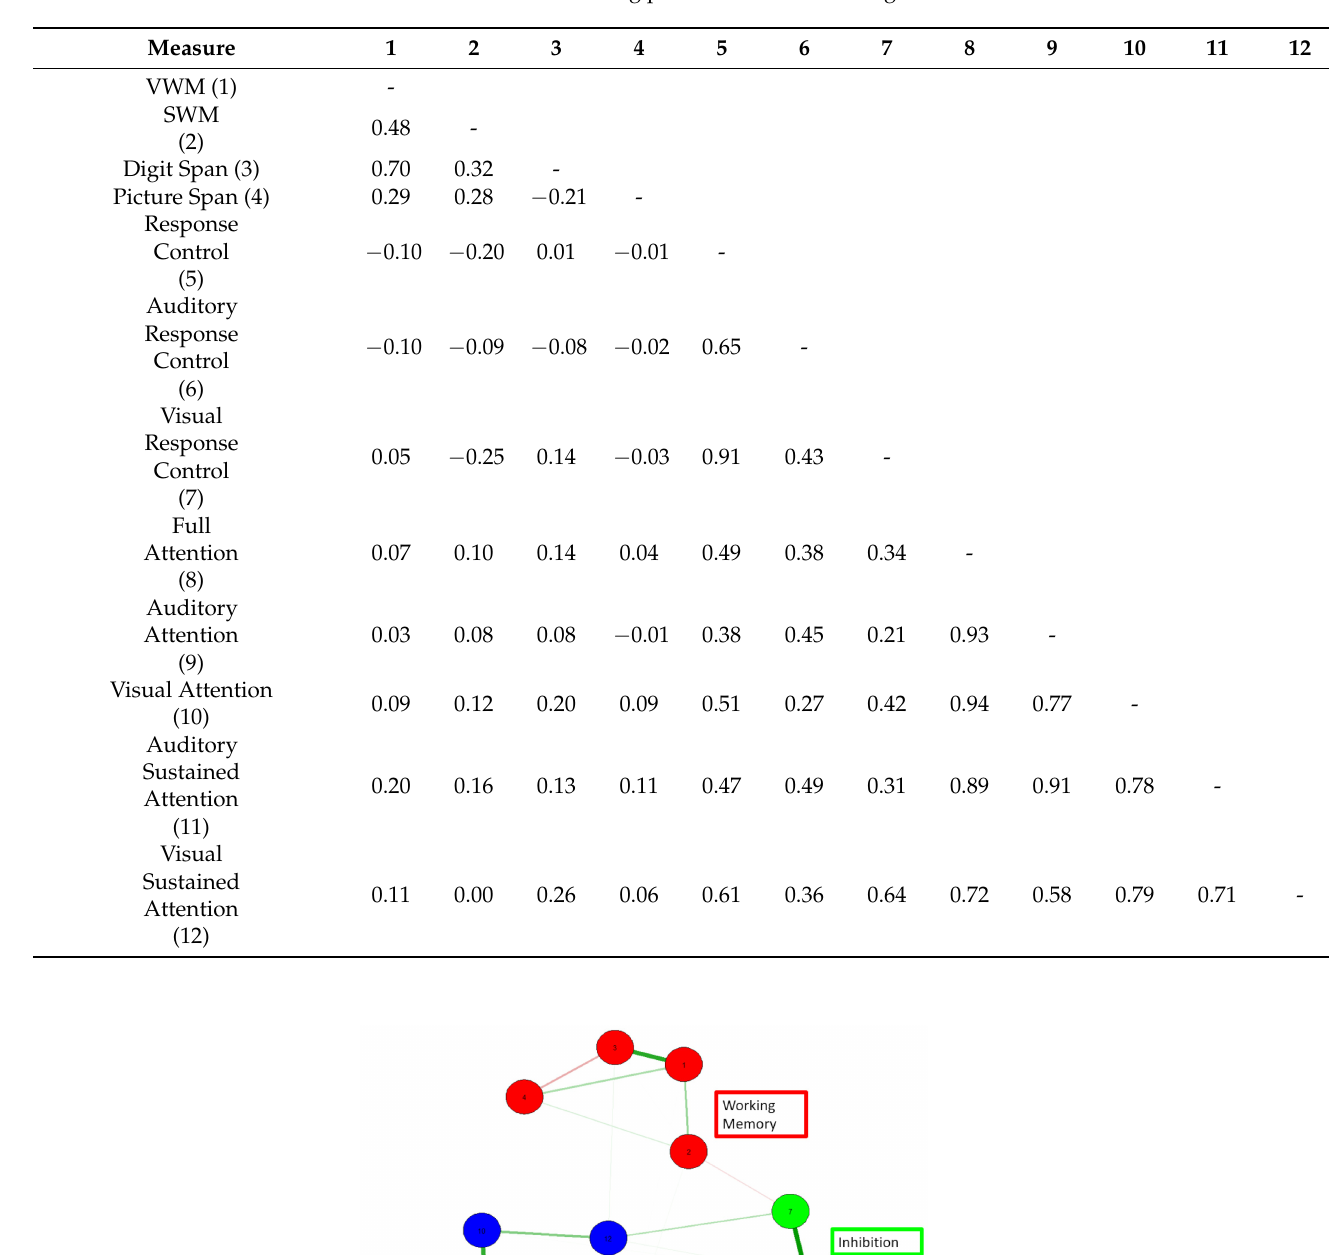
Table 3. Correlations among post-test measures of cognition.